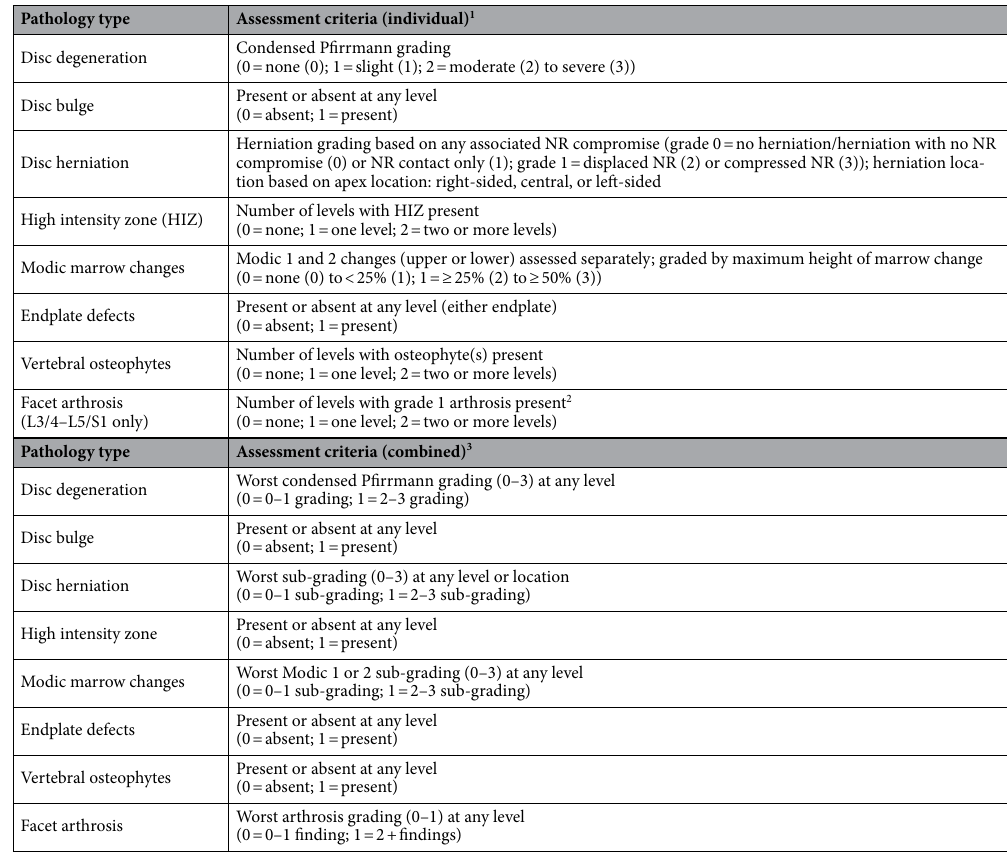
Table 1. Pathology variables and assessment criteria. 1 Each pathology assessed from L2/3 through L5/S1 unless otherwise indicated. 2 Grading based on number of different degenerative findings (out of 8) present (grade 1 = two or more findings). 3 Each pathology scaled at 0 or 1 to standardize analysis of any combinations. NR, nerve